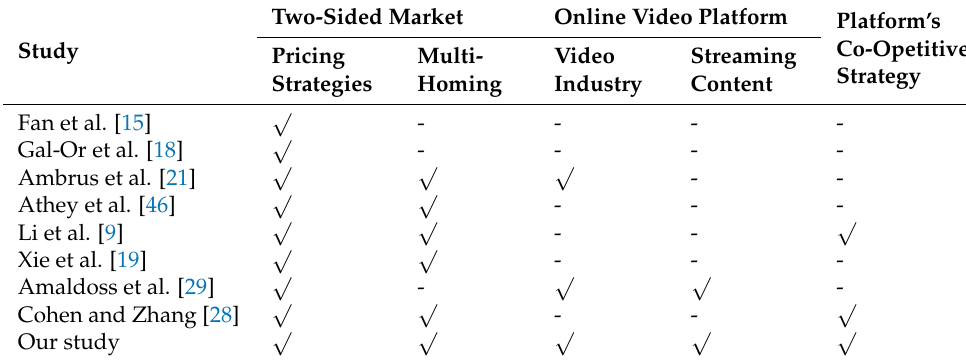
Table 1. Comparison with the related studies.